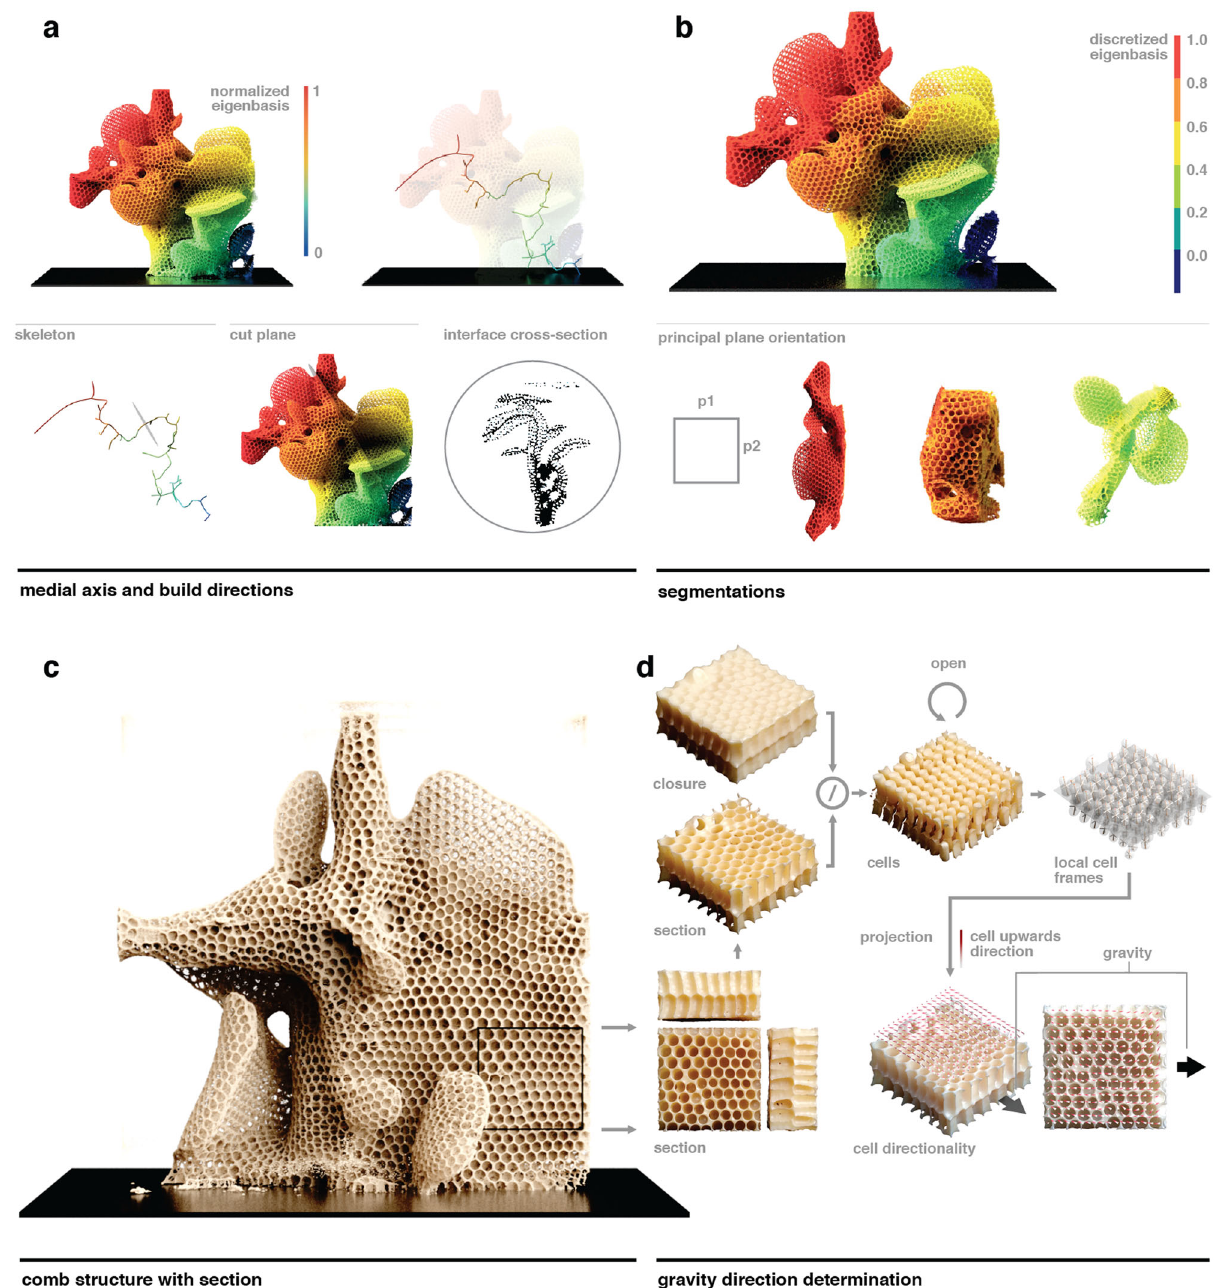
Fig. 5 Development of global descriptors of comb and building processes. a Curve skeletons and cross-sections are shown, dividing the combs at their medial plane. These cross-sections bisect cells along with the interface so that their depth, thickness, and pitch can be measured at any point. b Comb regions that share similar principal directionalities are shown. c By combining established knowledge of A. mellifera building behavior and computational analysis of structure, we demonstrate that the gravitational direction at the time of construction can be reconstructed for a selected region of comb. d For the selected comb region, morphological and combinatorial operators were used to extract individual cells, by subtracting the section itself from the closure of the section and then separating each cell by iterative opening operations. Once the internal volumes of individual cells were obtained, we computed an orthonormal basis for each cell using principal component analysis. For this comb selection, the principal axis of the orthonormal frame was almost orthogonal to the medial plane of the section and was projected onto the medial plane to reveal the upward tilt that bees typically build opposing the sensed direction of bisects more than one of the comb ’ s segmented regions. In this case, minimum-spanning tree that connects each region of the Fiedler volumetric data from the segmented region corresponding to that segmentation. The cross-sections of the volumetric data-oriented to point ’ s isocontour displayed a perpendicular view of the comb ’ s the curve skeleton ’ s tangent indicate that the comb ’ s interface falls in interface, but data from the other regions may not. line with the curve skeleton ’ s normal. These cross-sections bisect Fiedler segmentation was also used to isolate comb regions that cells along with the interface so that cell depth, thickness, and pitch share similar principal directionalities. Comb segments with can be measured at any point. In some cases, the selected plane